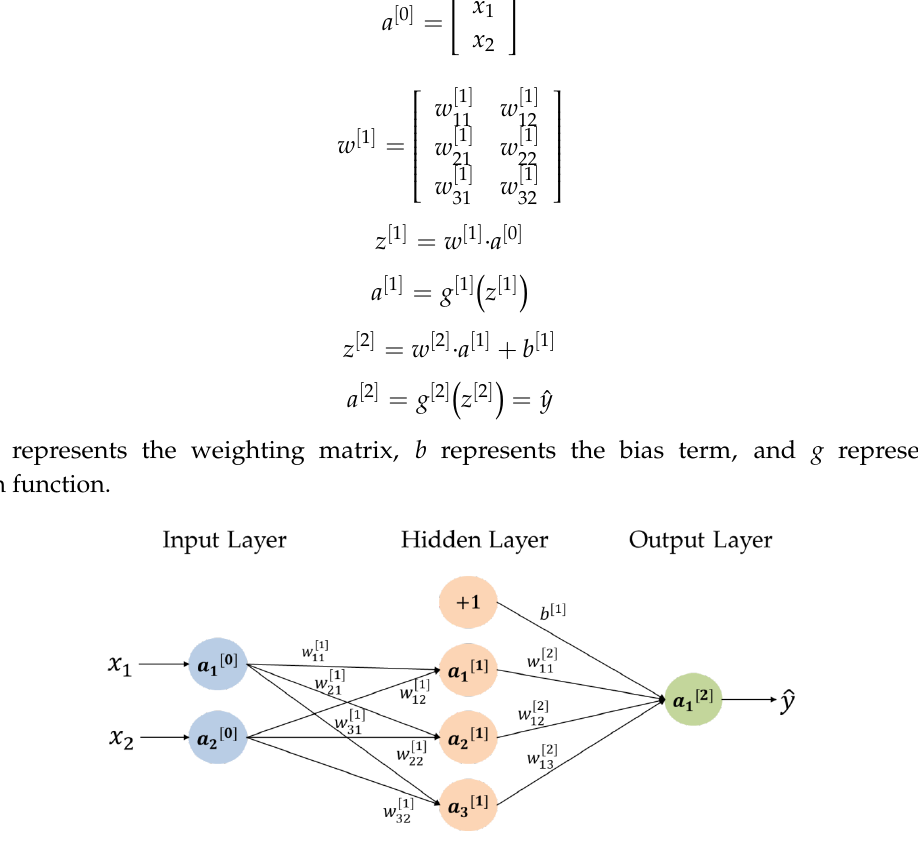
Figure 2. Multilayer perceptron with dual inputs, a single hidden layer and a single output.